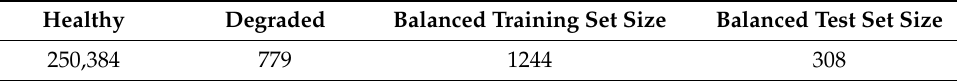
Table 6. Resulting size of balanced classes for healthy and faulty